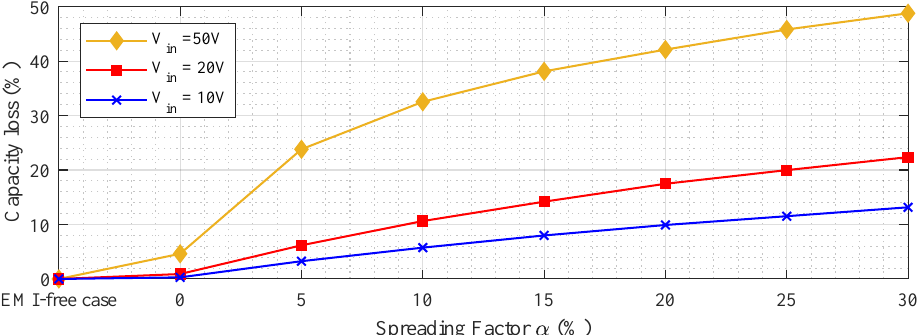
Figure 10. The PLC channel capacity loss in the case of several values of spreading factor with the change in input voltage amplitude of the